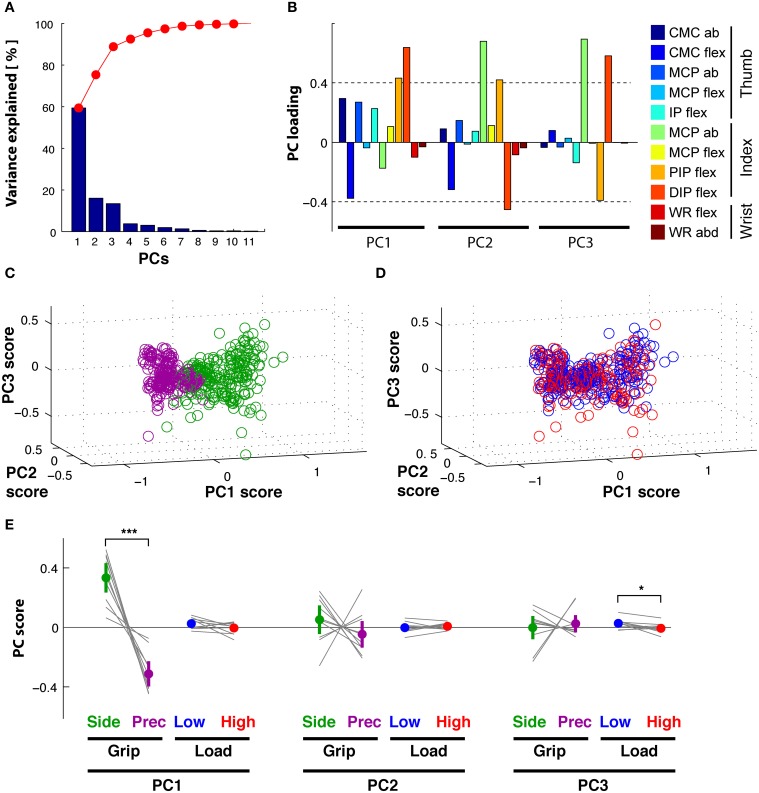
Hold period: PCA on kinematics. (A) Scree plot: percentage of explained variance in the kinematics by each PC (blue bar, Eigenvalue in %) and cumulative percentage explained (red). (B) Loadings of each DoF (color-coded) per PC. (C) PC space formed by the first three PCs: each trial (circle) is represented by its PC scores. PC1 visibly separates side grip trials (green) from precision grip trials (purple). (D) PC space of the first three PCs: no visible separation of low (blue) vs. high (red) load force trials in the PC scores (but see E). (E) Average PC scores (colored dot) and ±95% confidence interval (colored vertical bar) for each PC and task condition (thin gray lines correspond to the average scores for each subject). Significant difference in average PC scores on PC1 for grip type and in PC3 for load condition (note: this latter difference is, however, not visible in the PC space D).